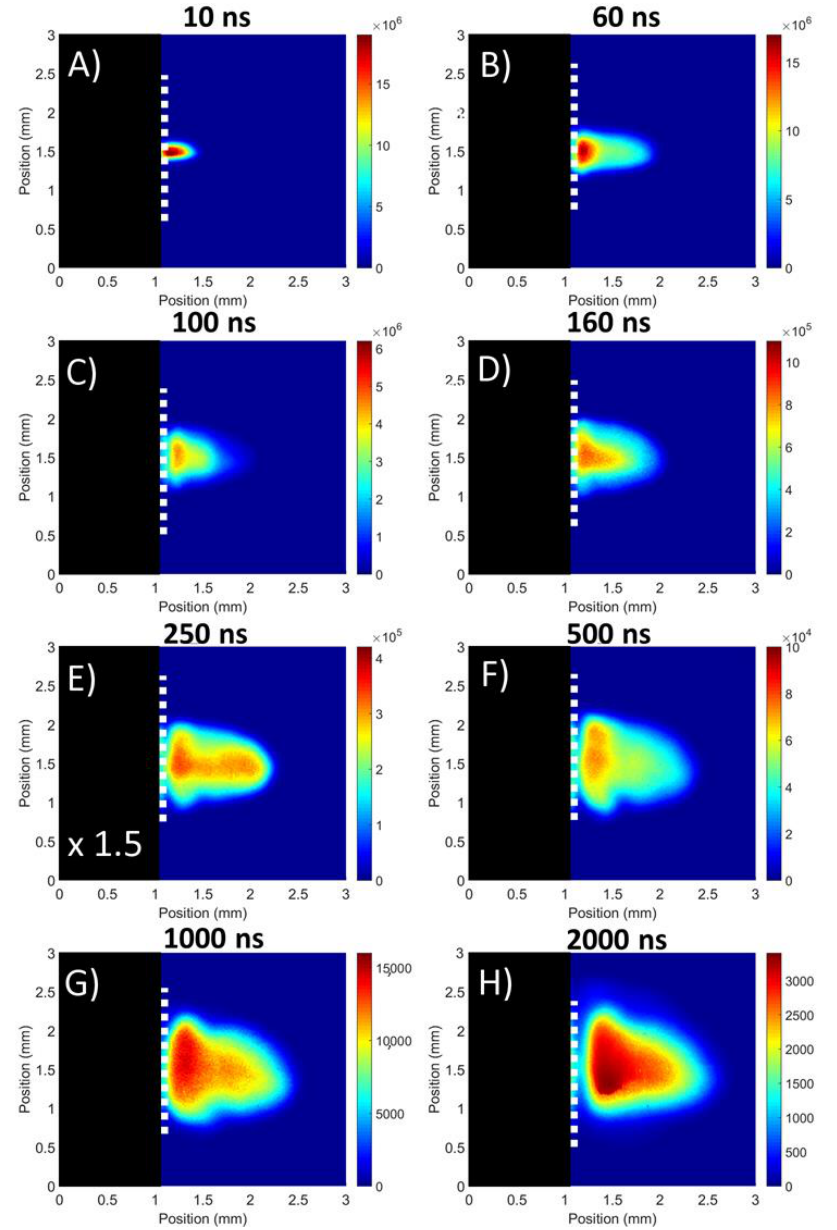
Figure 2. Images ( A – H ) of the evolution of a laser plasma created on the flat target. The broadband images have been normalised at each time-step across all targets for ease of comparison.